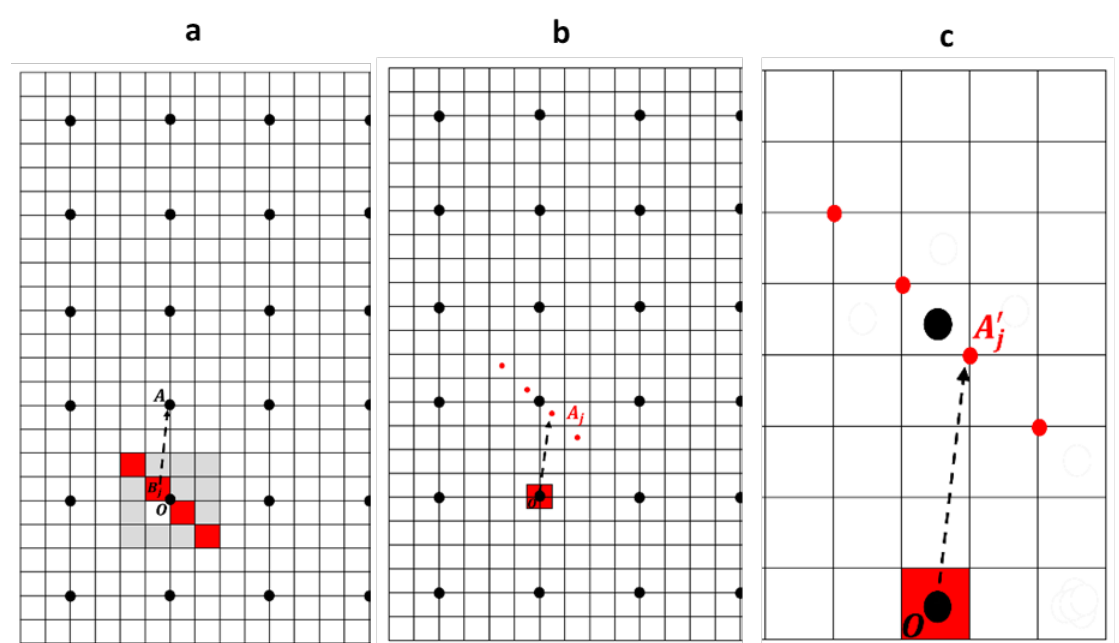
6 of 12 Figure 3. 2D representation of a dislocation loop in a tilted plane on a ( 8 × 8 ) fast Fourier transform (FFT) grid: ( a ) with a homogeneous eigenstrain 𝜺 ∗ in the voxels occupied by the dislocation loop; ( b ) with each voxel subdivided into 4 × 4 sub-voxels, only 4 of which have a 4 𝜺 ∗ eigenstrain field. In order to compute the displacement due to sub-voxels, we use a 𝑁 × 𝑁 ( 𝑁 × 𝑁 × 𝑁 ) grid for 2D (resp. 3D) problems where each voxel can be subdivided into 𝑛 × 𝑛 ( 𝑛 × 𝑛 × 𝑛 ) sub voxels. Only n ( 𝑛 × 𝑛 ) sub voxels are submitted to an eigenstrain field. At a point 𝑨 of the grid (black dots, Figure 4a), we need to compute the sum of the displacements 𝒖 𝒊𝒋 due to the n ( 𝑛 × 𝑛 ) sub voxels j (center 𝑩 𝒋 ) within a voxel centered at point 𝑶 . This sum is equivalent to the sum of the displacements due to a strained sub voxel at point 𝑶 on the grid points 𝑨 𝒋 such as 𝑶𝑨 𝒋 = 𝑩 𝒋 𝑨 (Figure 4b). It is also equivalent to the sum of the displacements 𝒖′ 𝒊𝒋 due to a full voxel at point 𝑶 on the initial grid on points 𝑨′ 𝒋 such as 𝑶𝑨′ 𝒋 = 𝑛𝑩 𝒋 𝑨 (Figure 4c). The only difference between these last two sums is due to the long-range strain field, and approximately results in a linear drift of the displacement.